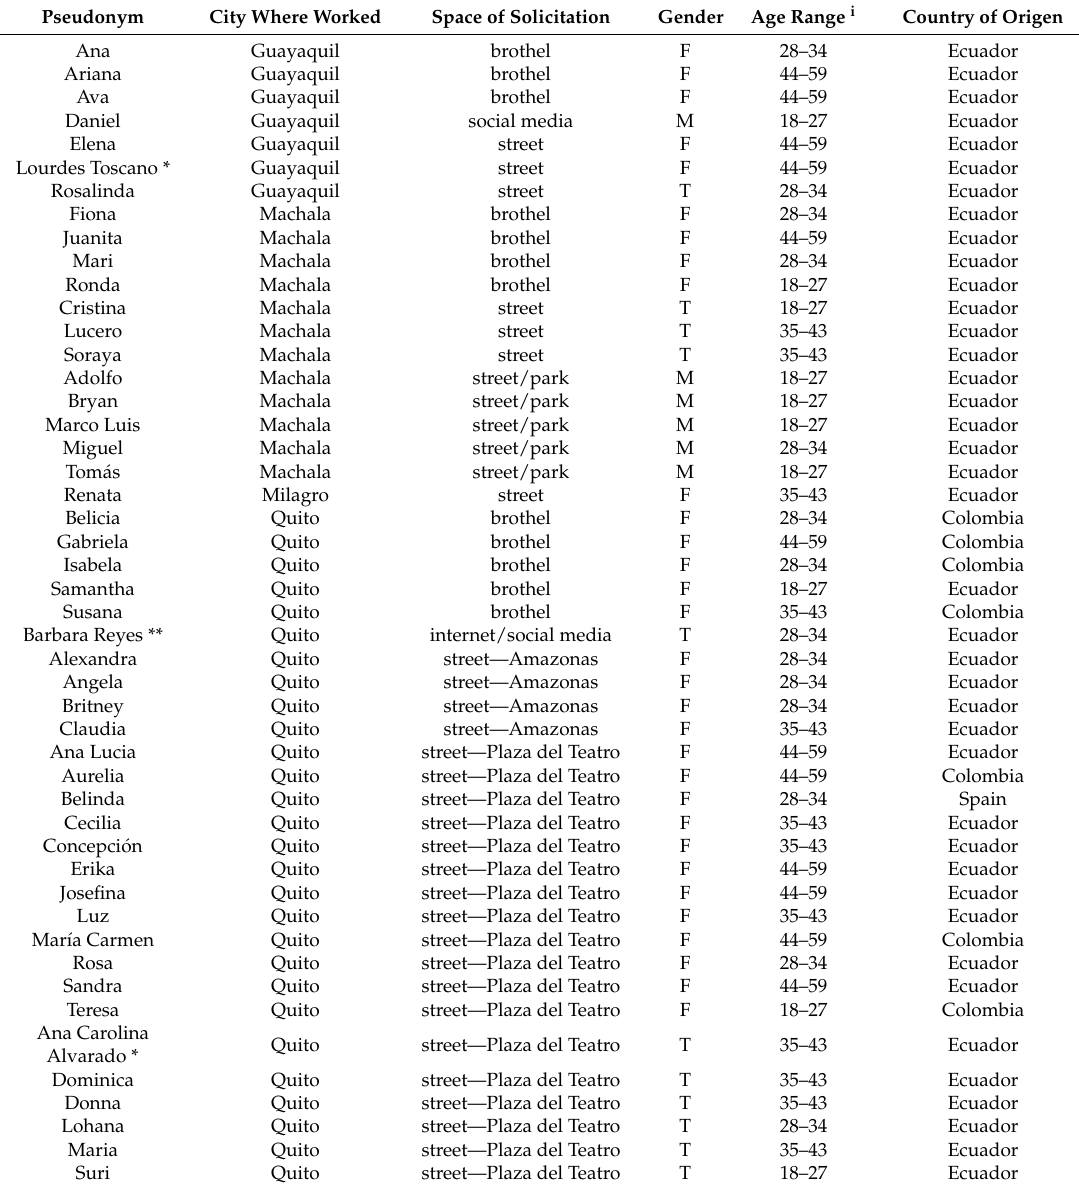
Table A4. Personal interviews with sex workers in